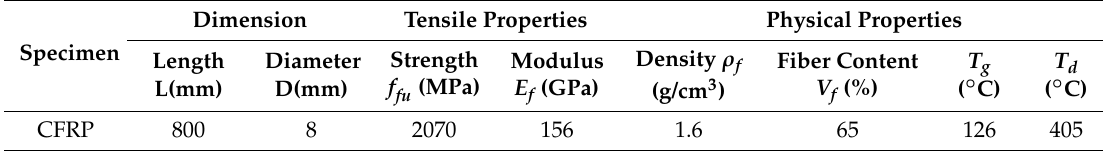
Table 1. Material properties of carbon fiber reinforced polymer (CFRP) tendons used.